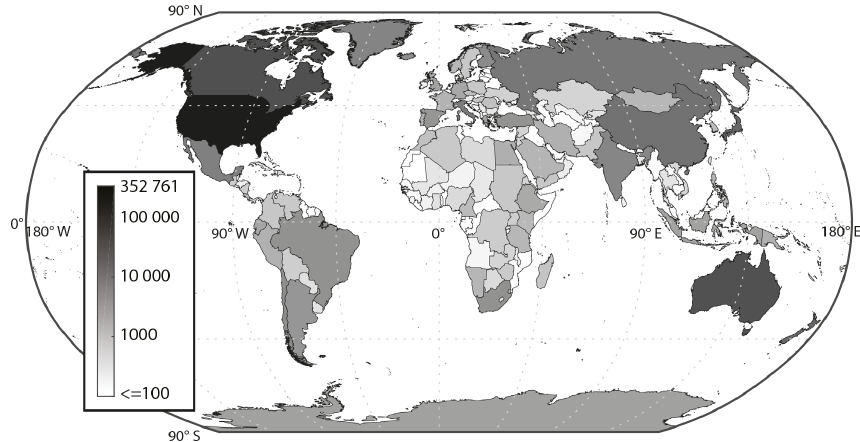
Figure 3. Spatial distribution of geochemical samples. Countries are shaded based on the number of data points within the polygons.